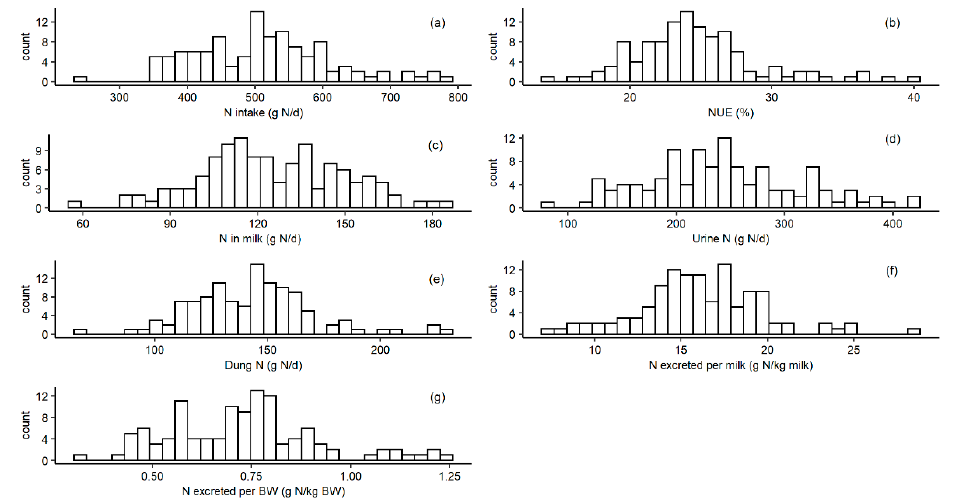
Figure 2. Histograms for ( a ) Nitrogen (N) intake ( b ) Nitrogen use efficiency (NUE), ( c ) N in milk, ( d ) Urine N, ( e ) Dung N, ( f ) N excreted per milk and ( g ) N excreted per body weight (BW) Count = Number of observations.